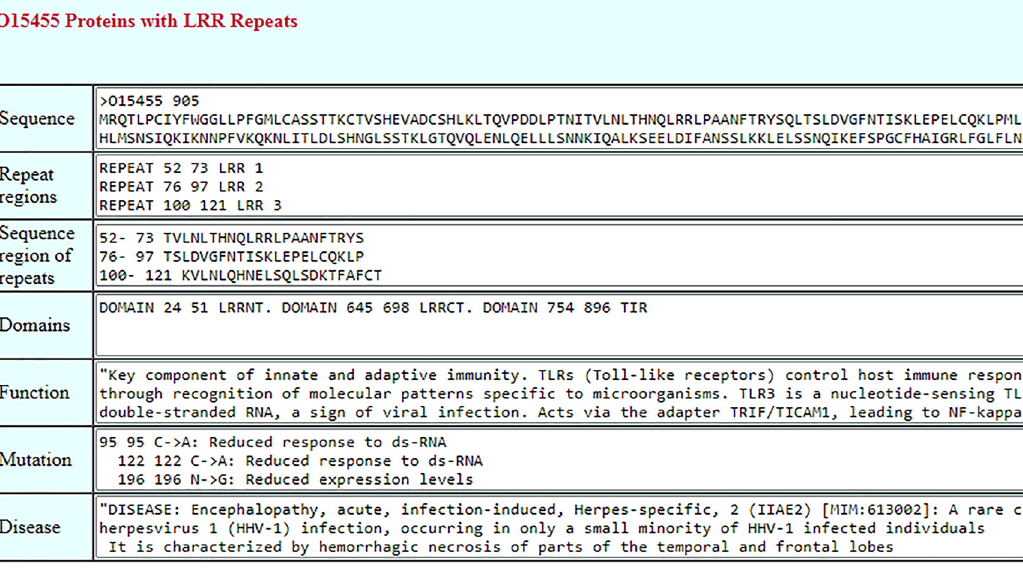
Figure 4: The Toll-like receptor 3 (O15455) protein with mutations in the residues (95 C->A: 122 C->A: 196 N->G: 247 N->R) of LRR repeats cause the reducing the response to double-stranded RNA that lead to acute infection-induced (herpes-speci fi c) encephalopathy-2